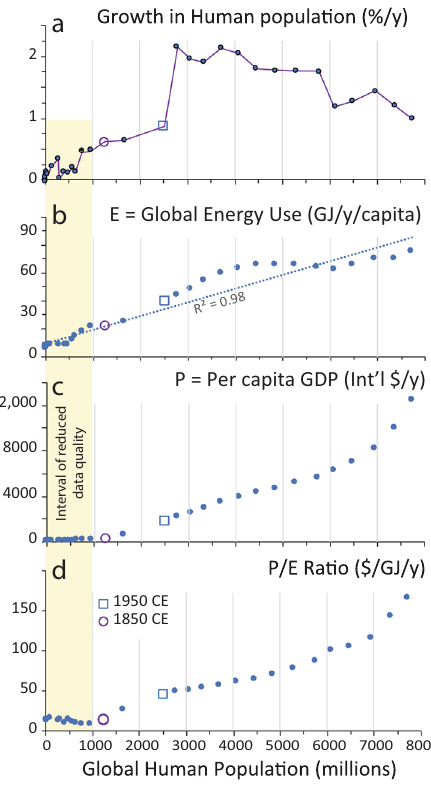
Fig. 2 Relationships between human population (millions) and key economic indicators. Relationships between human population (millions) and key economic indicators: a rate of population growth (%/y), b energy consumption per capita ( E in GJ/y/capita), c per capita productivity ( P as GDP in 1990 international dollars, $/y/capita), and d P/E ratio, each across Holocene and Anthropocene epochs. Purple circle = 1850 CE; blue square = 1950 CE. A marked change in GDP per capita after 1850 CE re fl ects the global spread of industrialization and technology. The rate of change in population sharply increases around 1950 CE. The P/E ratio fell for most of the Holocene, until 1850 CE, when human society became more productive per unit energy use. Data references are listed in Supplementary Online Material.